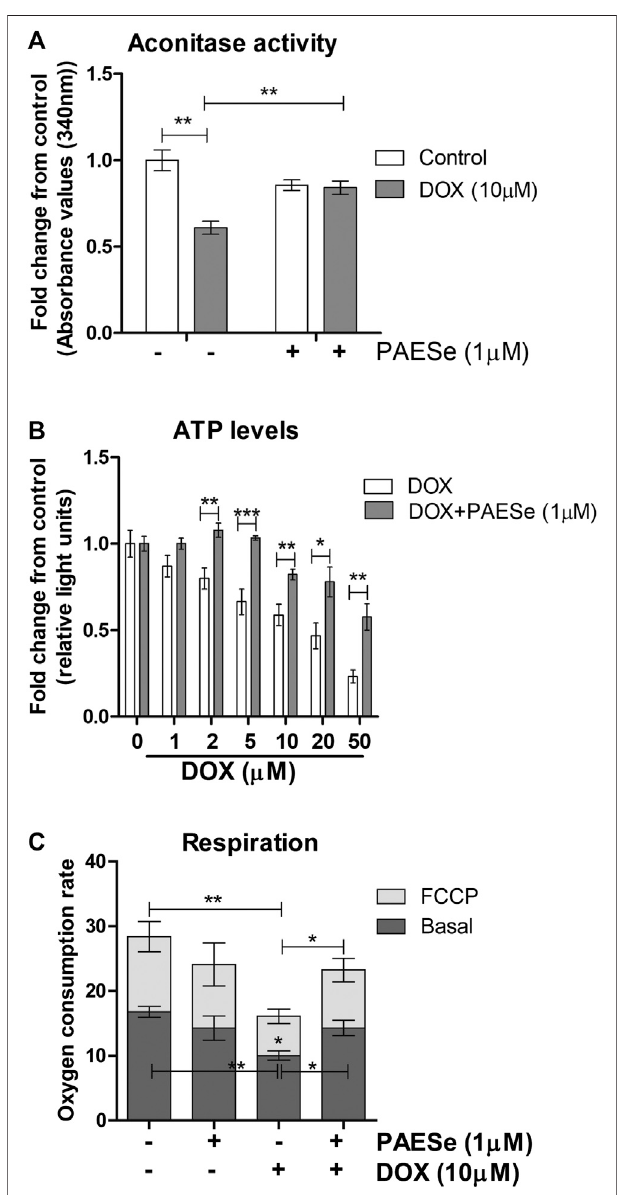
FIGURE 6 | PAESe protects against DOX-mediated attenuation of mitochondrial bioenergetics. (A) H9C2 cells were treated as following; control (media), DOX (10 µm), PAESe (1 µM), and DOX (10 µM) + PAESe (1 µM). Mitochondrial isolations were extracted from cells for aconitase activity assay. Values were standardized to total protein concentrations, based upon on a standard curve of enzyme activity from the kit, and compared to control levels. (B) ATPlevelsweremeasuredfromH9C2cardiomyoblaststreatedwith increasingconcentrationsofDOX(0 – 50 µM),for24 htreatedwithandwithout PAESe (1 µm) (N (cid:2) 4 independent experiments with three repetitions and values are based upon averages ± SEM. (C) Mitochondrial respiration (basal and uncoupled (FCCP)) in H9C2 cardiomyoblasts were measured following DOX (10 µm) with our without PAESe (1 µm) for 24 h. Values were normalized to total protein levels. The mitochondrial complex activity was decoupled by adding Tri fl uorocarbonylcyanide (FCCP; 6 µM), where N (cid:2) 4 independent experiments. (* p < 0.05,** p < 0.001, *** p < 0.0001; Mean ± SEM, N (cid:2) 4 independent experiments with N (cid:2) 3 repetitions per group).